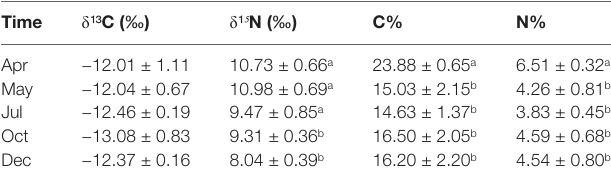
Data presented as mean ± SD, n = 3. Values in the same column bearing different letters are significantly different (p < 0.05).